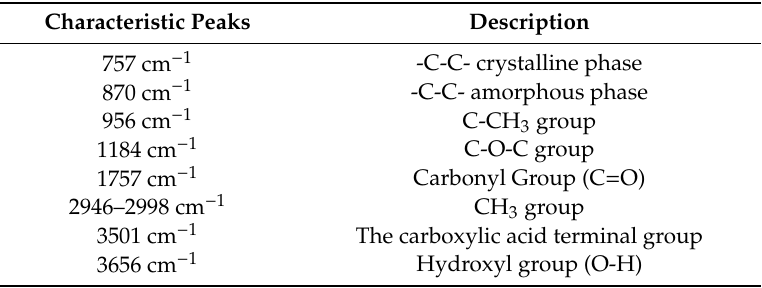
Table 3. Description of diverse characteristic peaks for the neat PLA